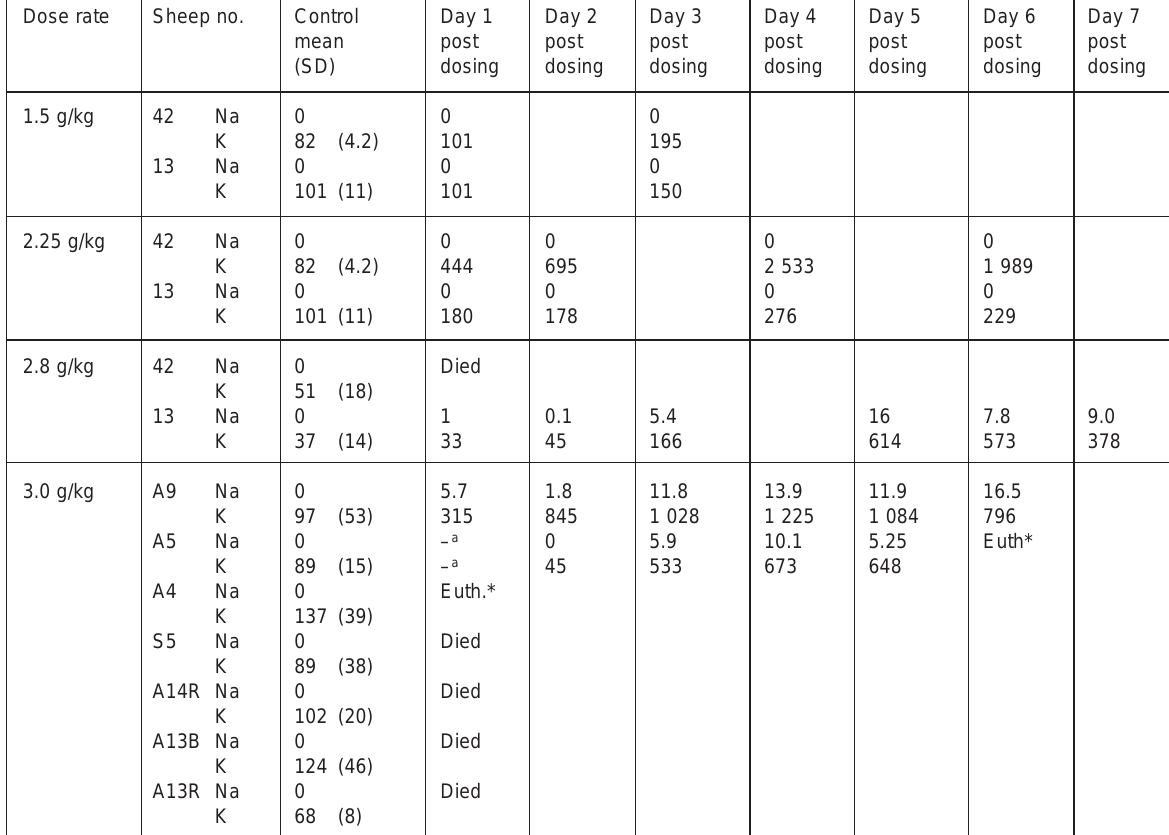
TABLE 4 Fractional excretion of sodium (%) and potassium (%) in sheep—control values and values following dosing with Nolletia gariepina Dose rate Sheep